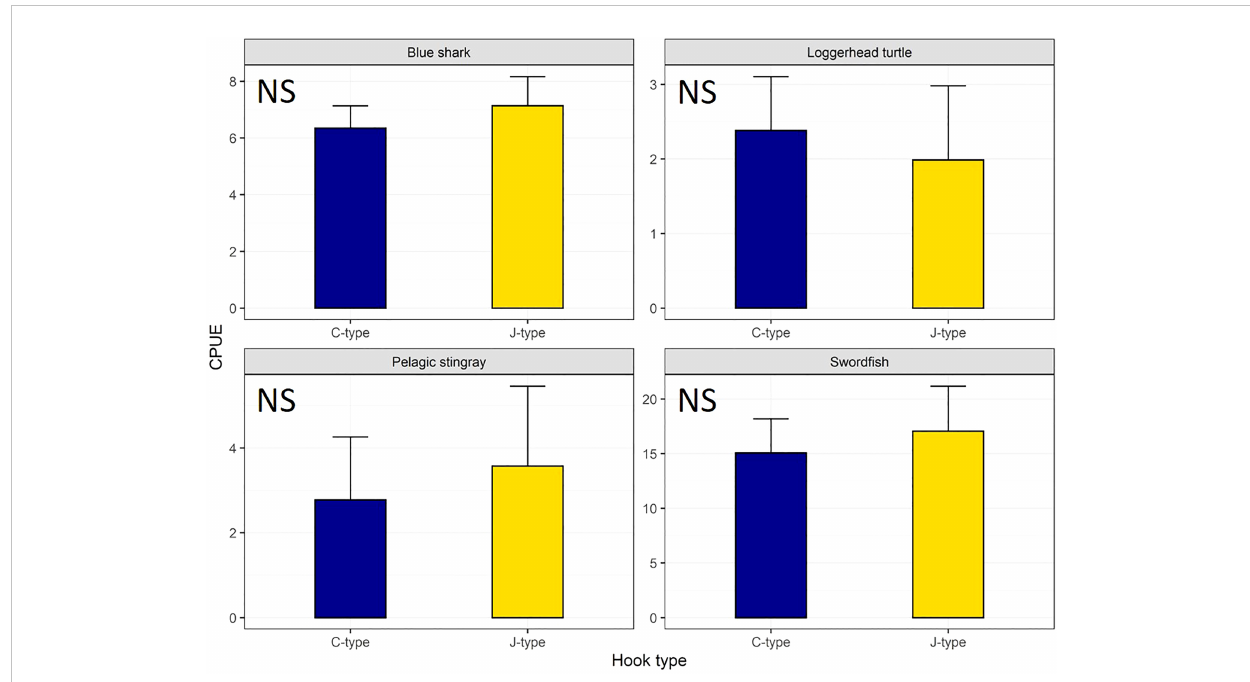
FIGURE 4 Catch-per-unit-effort (CPUE; mean ± se) by species (blue shark, loggerhead turtle, pelagic stingray, and sword fi sh) and hook type (C and J). NS, not signi fi cant (Wilcoxon ’ s test; p >.05).